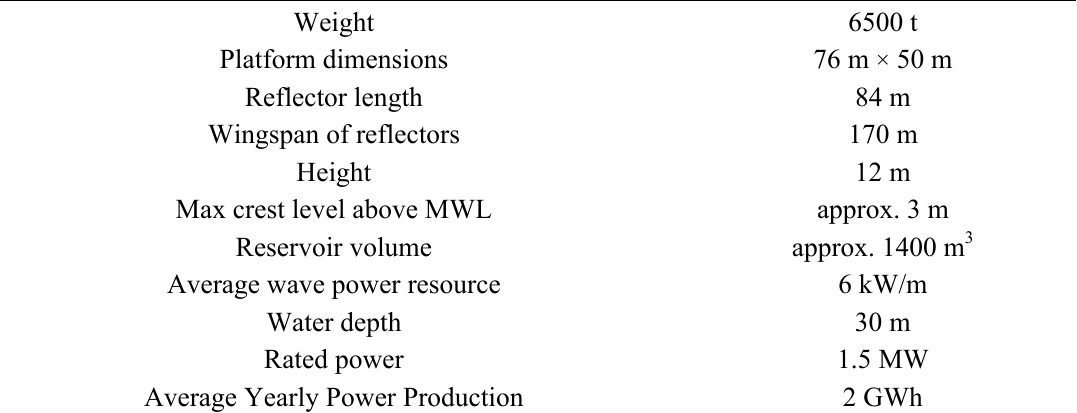
Table 1. Features of Wave Dragon DanWEC